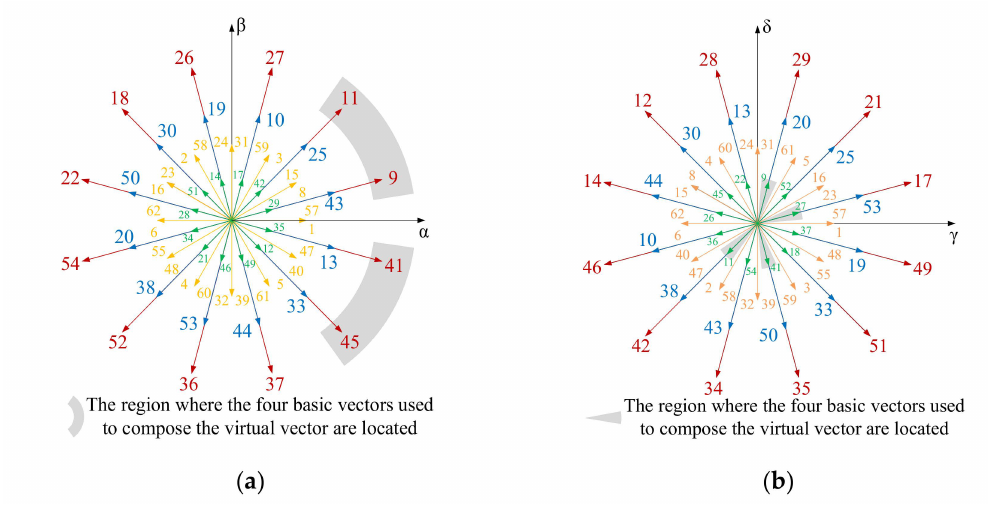
Figure 3. The projection of voltage vectors. ( a ) Subspace ( α , β ); ( b ) Subspace ( γ , δ